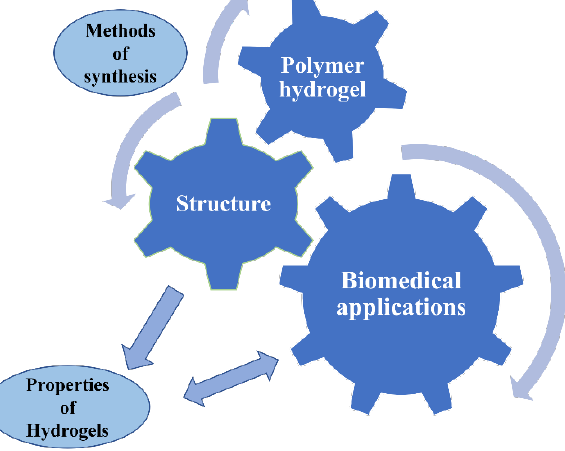
Figure 6. Schematic representation of structure-effect relationship of polymer gels.